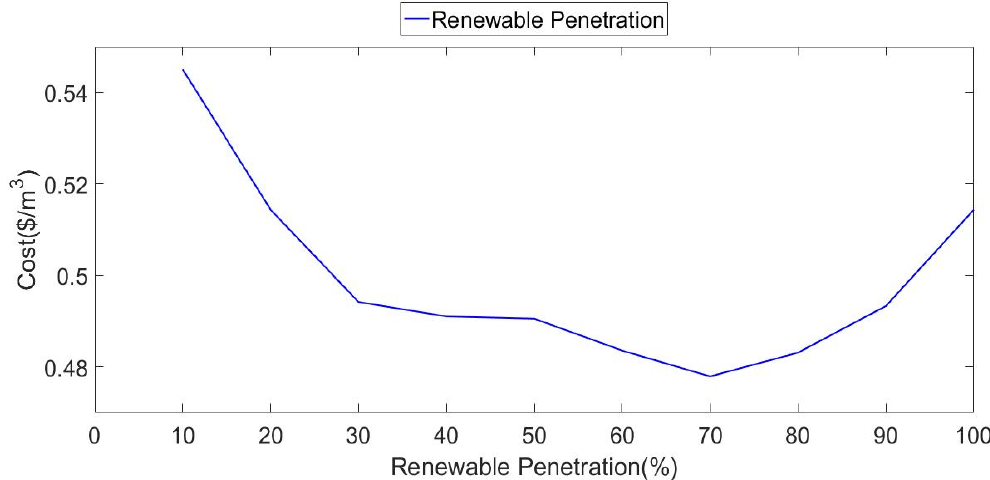
Figure 11. Minimized total annual cost as a function of the penetration constraint.